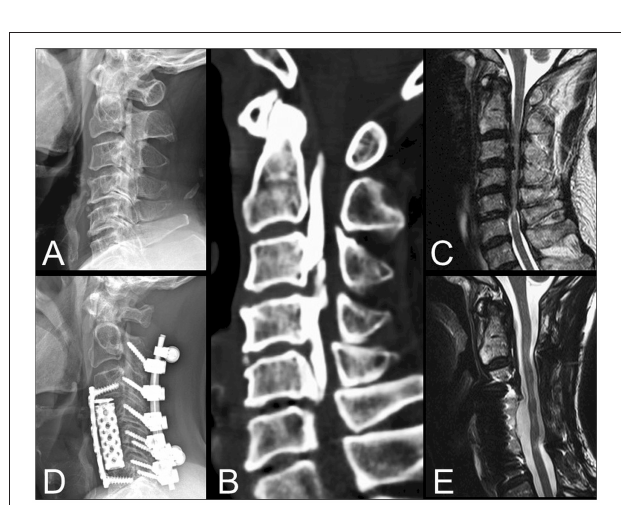
FIGURE 3 | Illustration of a 61-year-old male who presented with progressive bilateral clumsiness of the hands, lower limb weakness, and unsteady gait for months. The lateral view of the cervical radiograph (A) and cervical CT scan (B) revealed the continuous type OPLL extending from C2 down to C5. The sagittal view of the cervical MRI also revealed severe compressive myelopathy from C2-6 (C) . Surgical intervention by circumferential decompression and fixation, including C2-C6 total laminectomy with posterior fixation, and C4-5 corpectomy with fusion, was performed (D) . The MRI at 2-years follow-up demonstrated good decompression of the spinal cord (E)